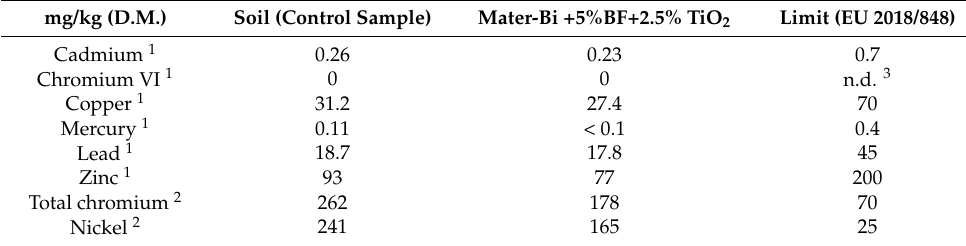
Table 20. Heavy metals analysis